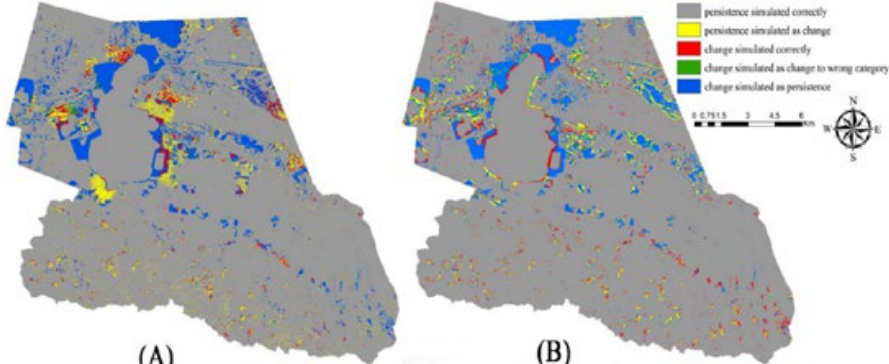
Fig. 7: Map of agreement and disagreement components in Fuzzy-AHP (A) and MLP (B) simulations